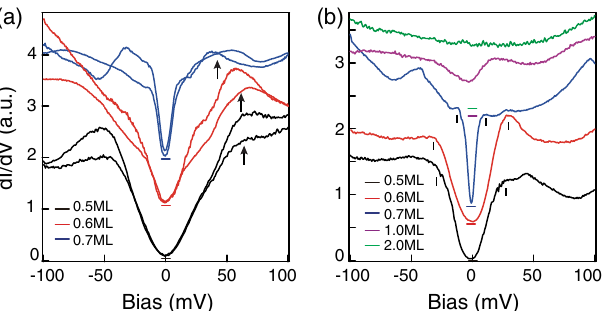
FIG. 3. K coverage dependence of d I =d V spectra. (a) The representative spectra taken at the HEG-dominated regions for various K coverages. Inhomogeneity of the pseudogap-like feature is illustrated by two spectra shown for each coverage. The arrows indicate the averaged energy locations of Δ H . (b) The representative spectra taken at the LEG-dominated regions for 0.5 – 0.7 ML K coverage and arbitrary regions for 1 – 2 ML K coverage. The curves are offset vertically for clarity, and the horizontal markers indicate the zero conductance position of each curve. The data were taken at 10 K for 0.5 ML, 20 K for 0.6 ML, and 4.5 K for 0.7 – 2 ML.